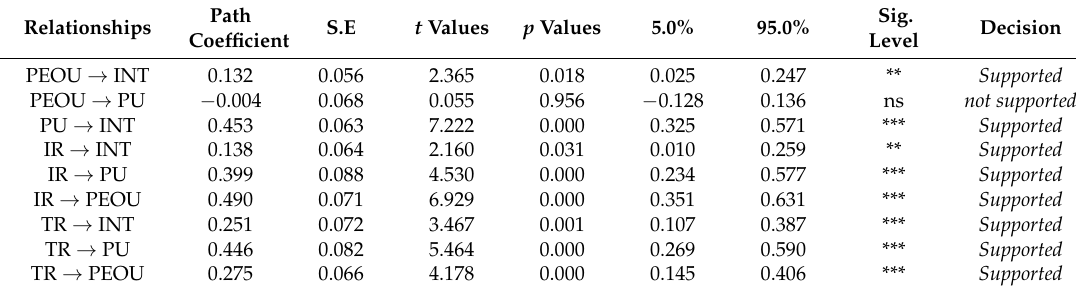
Table 5. Structural Model